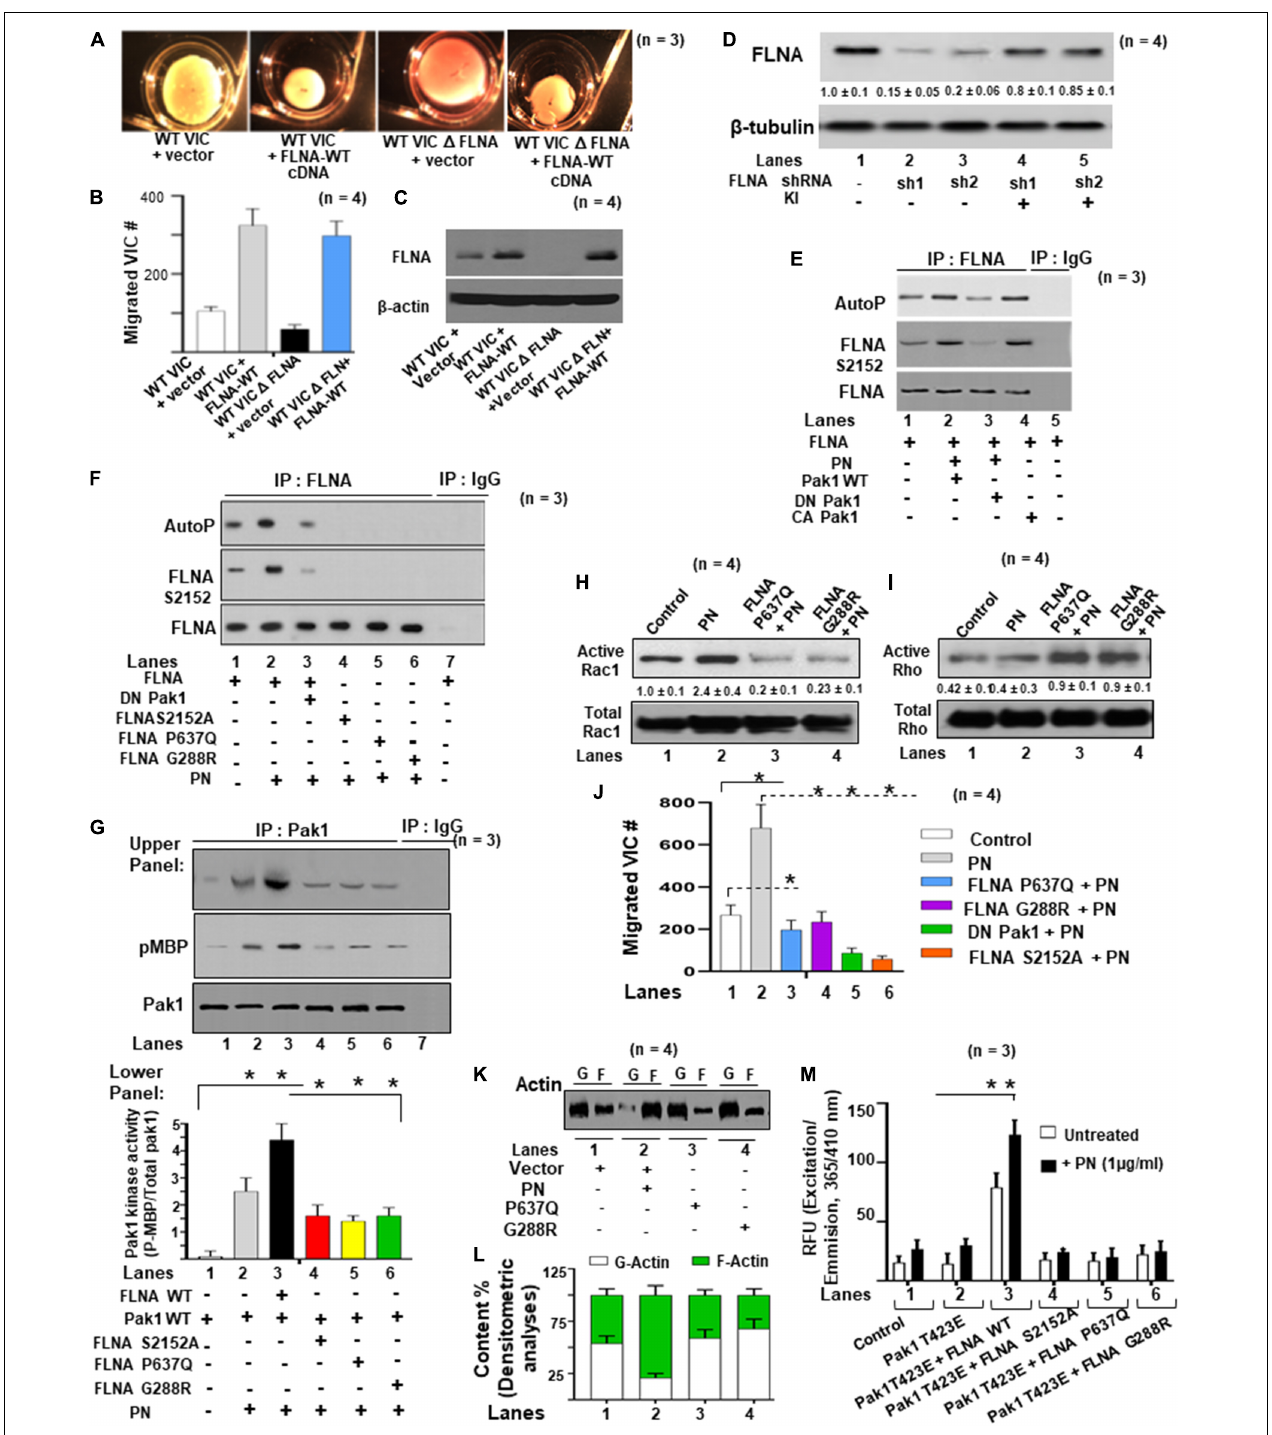
FIGURE 6 | FLNA is a substrate of Pak1, and the effects of FLNA mutations [FLNA (P637Q) and FLNA (G288R)] on PN induced FLNA phosphorylation, on activation of Rac1, and on cell migration are shown. (A) VICs were transfected with FLNA shRNA. The stable clones were isolated and designated as FLNA-deficient VICs (VICs (cid:49) FLNA) WT VICs and FLNA (cid:49) VICs were transfected with vector or with wild-type FLNA lentiviral constructs for 72 h before treatment. These transfected VICs were then embedded in three-dimensional collagen matrices to analyze collagen lattice compaction (see the “Materials and Methods” section for details). (B) Transwell migration assays are shown for WT VICs and VICs (cid:49) FLNA pre-transfected with the indicated lentiviral constructs. Percentages of cells seeded in the upper chamber of Transwell filters that migrated overnight into the lower chamber are shown. Numbers of migrated cells were counted on six fields from three experiments. Detailed descriptions are in the “Materials and Methods” section. (C) Western blot analyses are shown for FLNA